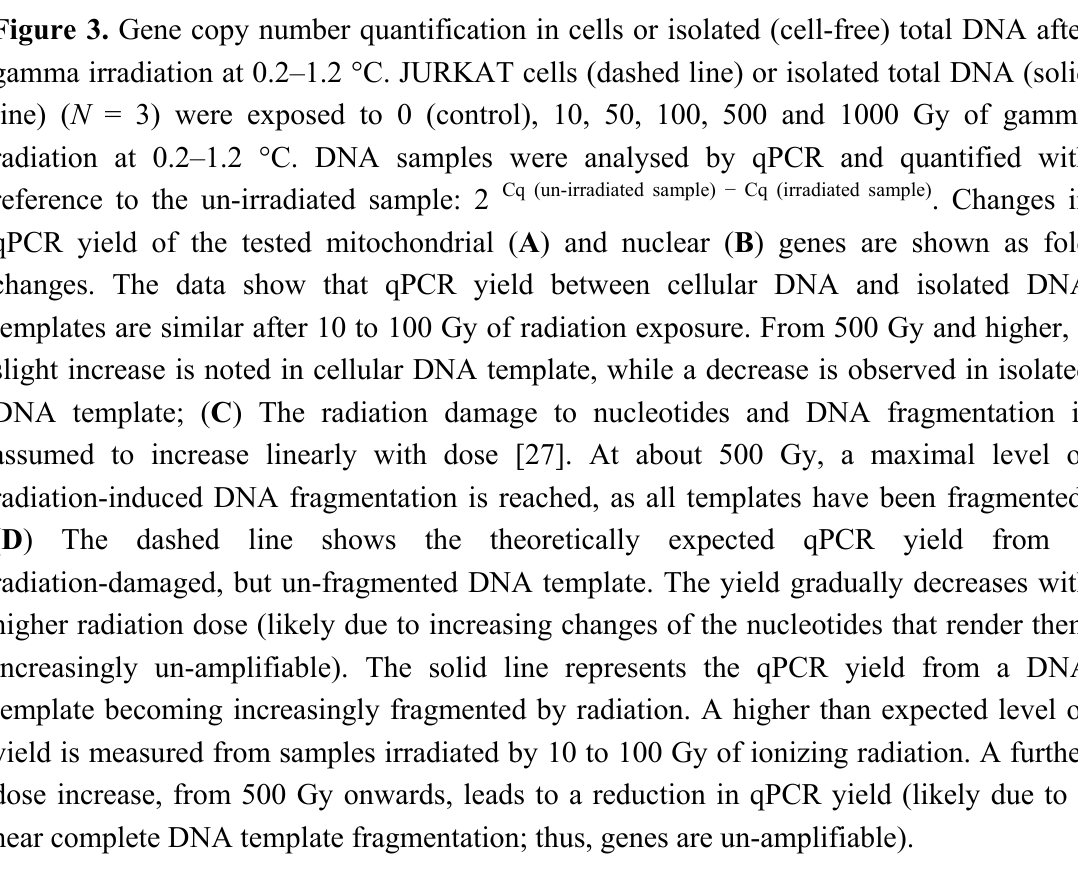
Figure 3. Gene copy number quantification in cells or isolated (cell-free) total DNA after gamma irradiation at 0.2–1.2 °C. JURKAT cells (dashed line) or isolated total DNA (solid line) ( N = 3) were exposed to 0 (control), 10, 50, 100, 500 and 1000 Gy of gamma radiation at 0.2–1.2 °C. DNA samples were analysed by qPCR and quantified